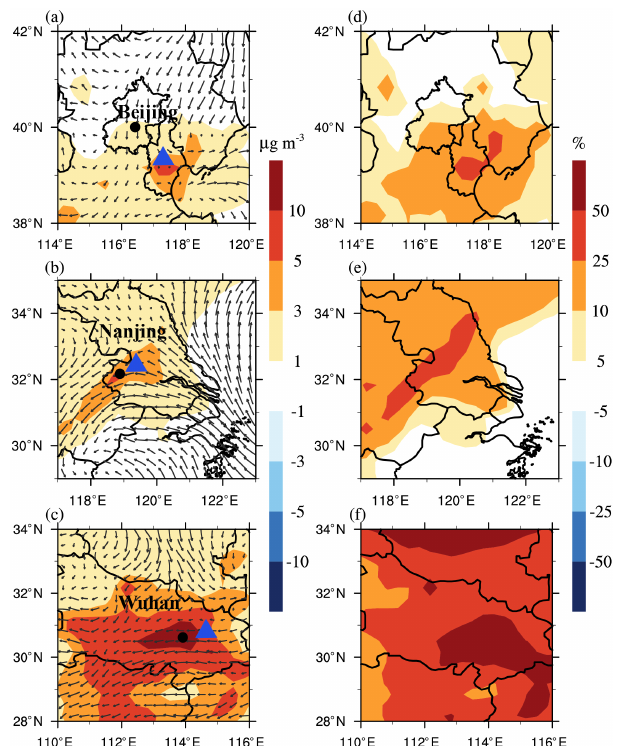
Figure 10. Daily averaged differences with overlaid wind field ( a–c , µgm − 3 ) and relative change ( d–f , %) of sulfate concentrations on a regional scale between SG and F0 at the surface, around (a, d) Bei- jing on 22 June, (b, e) Nanjing on 16 May and (c, f) Wuhan on 15 October. The difference was calculated as the simulation of SG minus F0. Black dots and blue triangles represent locations of the ground sites and plants, respectively.